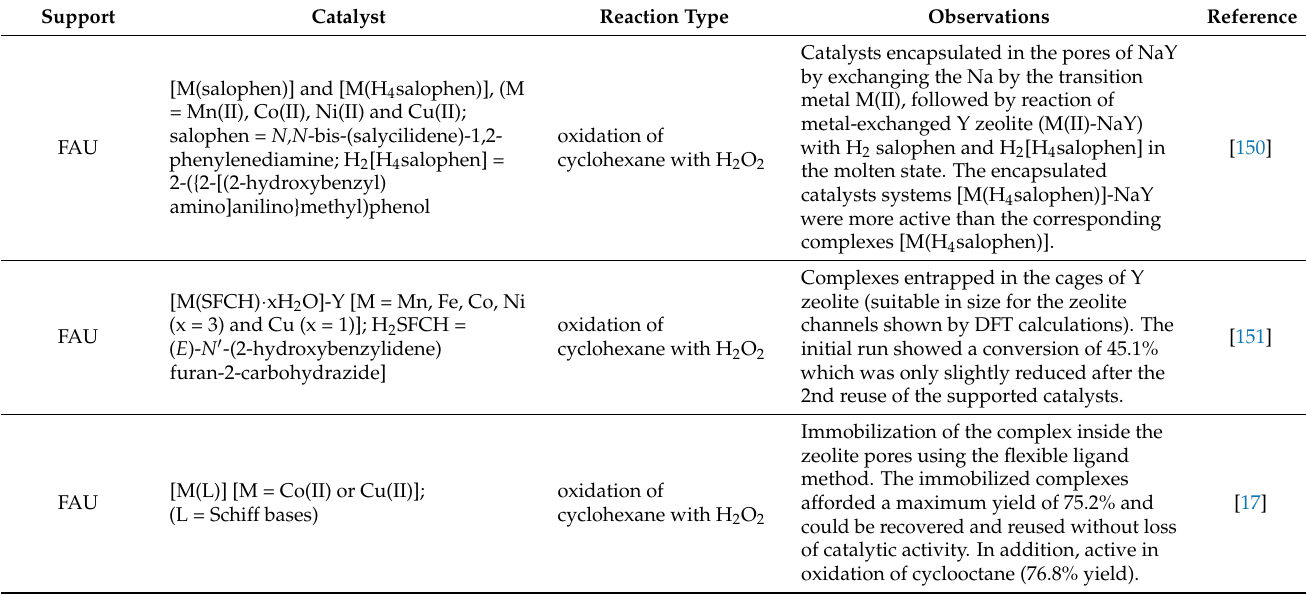
Table 3. Catalytic applications of commercial/hierarchical zeolites and other related materials as catalysts support for oxidation of